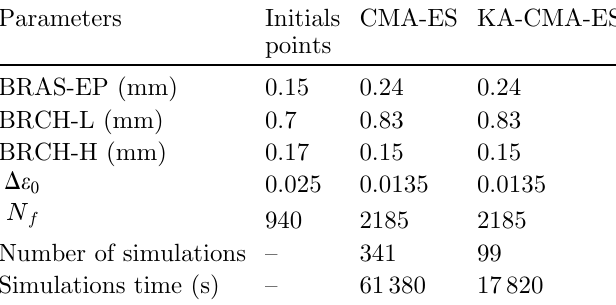
Table 5. Comparison between performance parameter for CMA-ES and